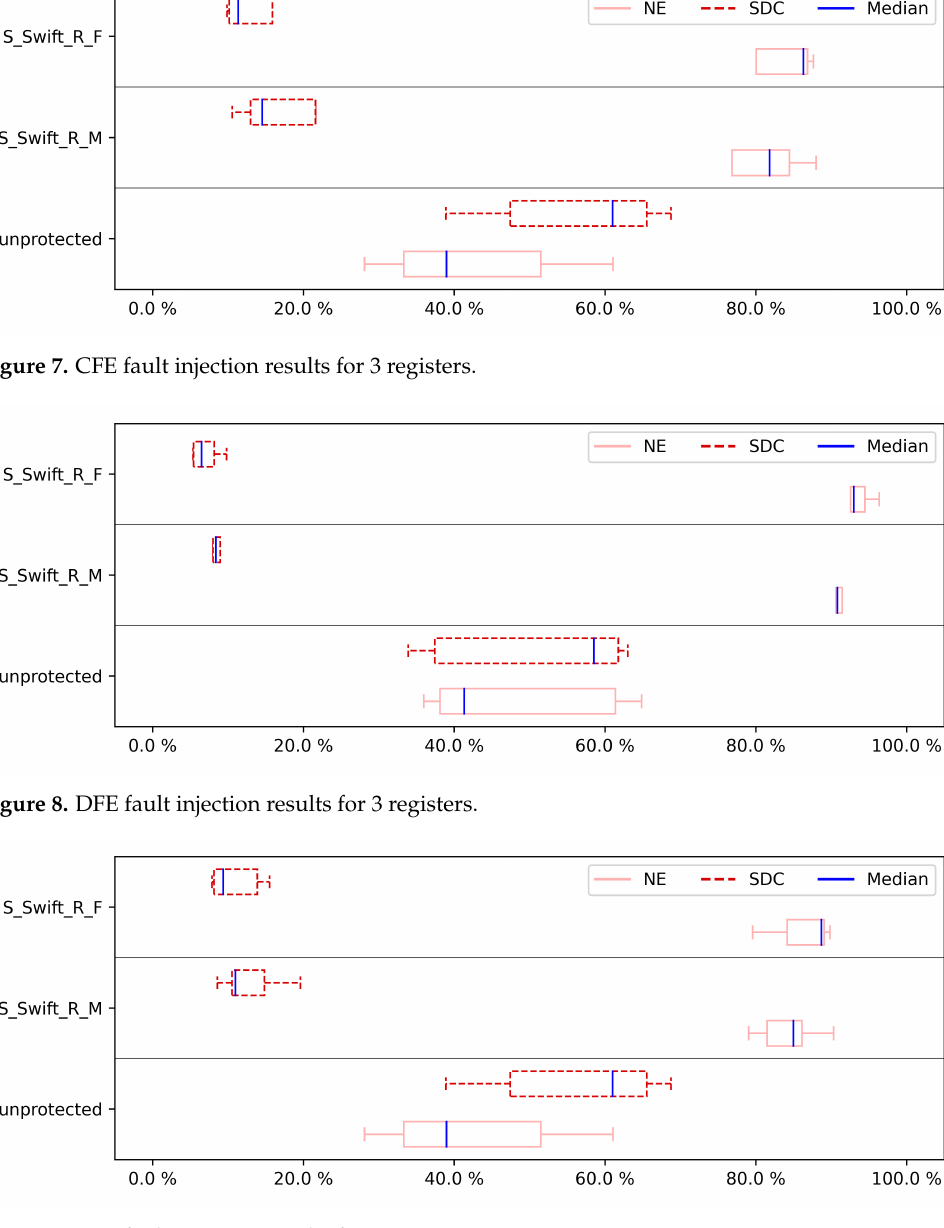
Figure 9. CFE fault injection results for 4